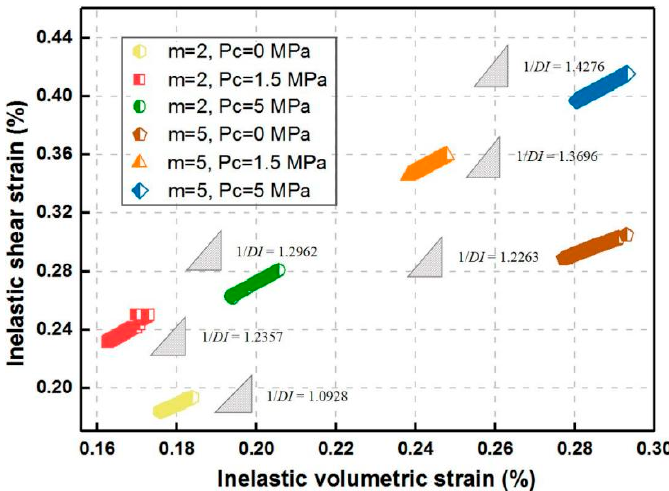
neity index ( m = 2) during uniaxial creep loading. ity index ( m = 2) during uniaxial creep loading.